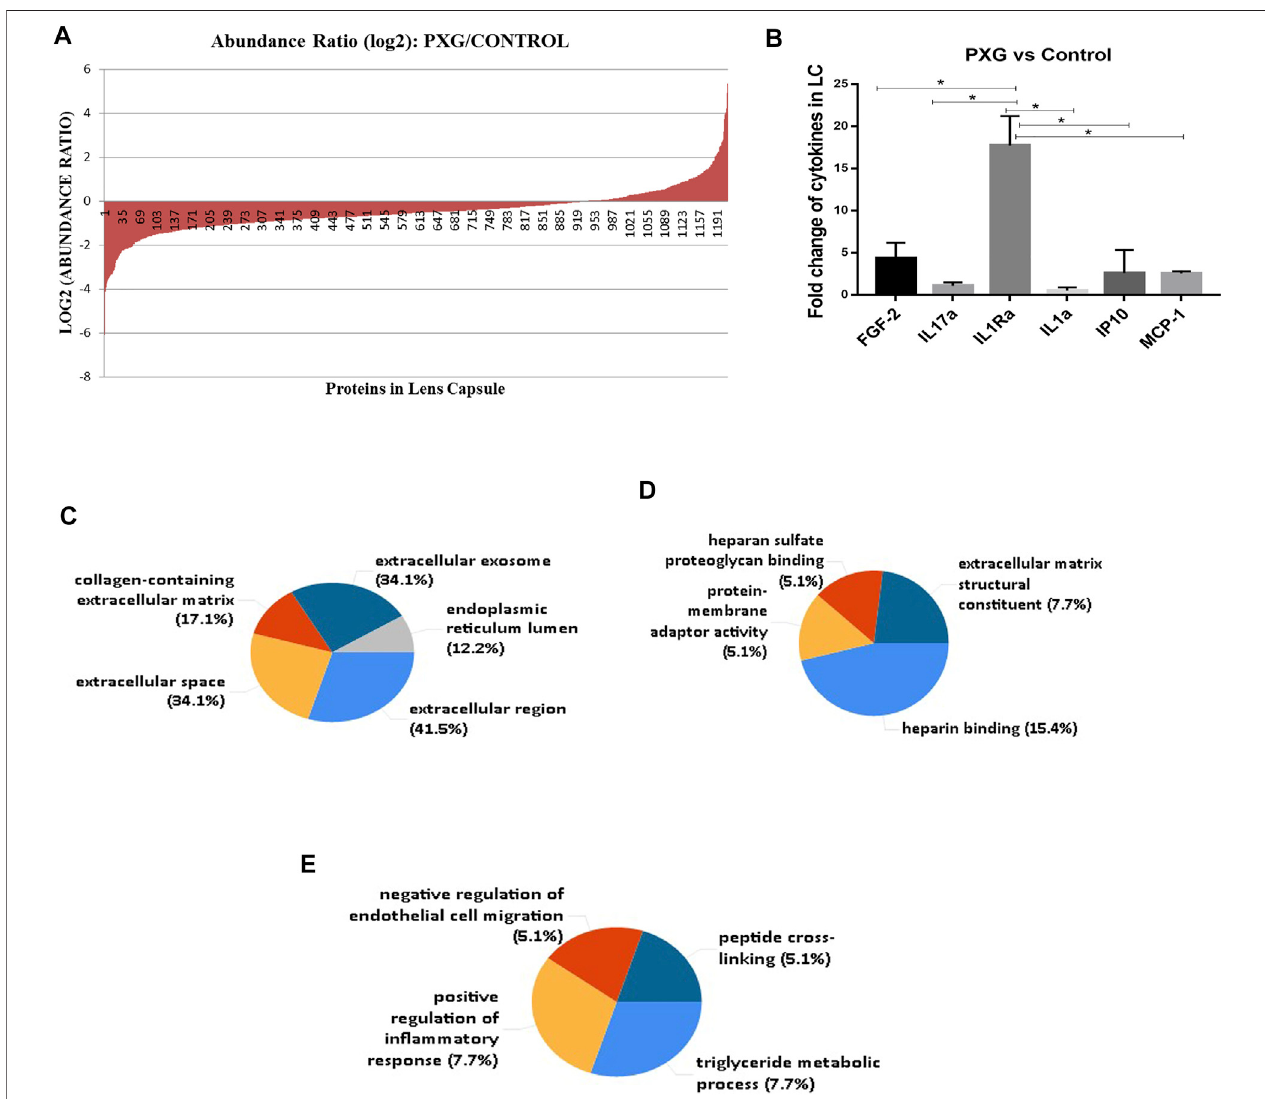
FIGURE 4 | Protein pro fi le in LC with PXG compared to the control. (A) Abundance ratios (log2) of proteins overexpressed or underexpressed are indicated in the graph. (B) Fold change of cytokines/chemokines using a bioplex kit assay with PXG compared to the control. (C) Functional enrichment protein analysis by the FunRich database tool using 43 proteins subjected to this analysis. The percentage of the cellular component highlights chylomicron more enriched in PXG. (D) Molecular functions such as heparan sulfate proteoglycan binding and protein-membrane adaptor activity are more enriched in PXG. (E) Biological process classi fi cations such aspeptidecross-linking are more enriched in PXG. Means ±SEM shown, * p < 0.05, ** p < 0.01, *** p < 0.001, **** p < 0.0001, one-way ANOVA post hoc t -test with Tukey correction, PXG-pseudoexfoliation glaucoma.